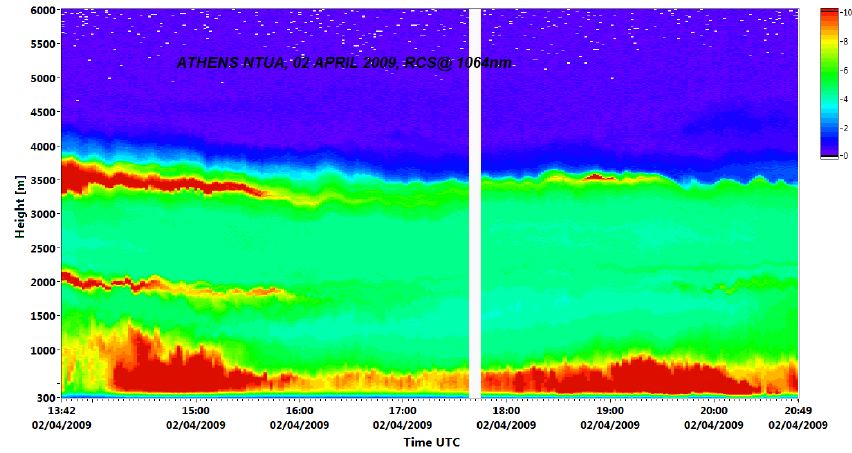
Fig. 3. Time-height cross section of the range-corrected backscatter lidar signal (in arbitrary units: AU) at 1064nm, as observed over Athens, by the NTUA Raman lidar system on 2 April 2009 (13:42–20:49UTC).